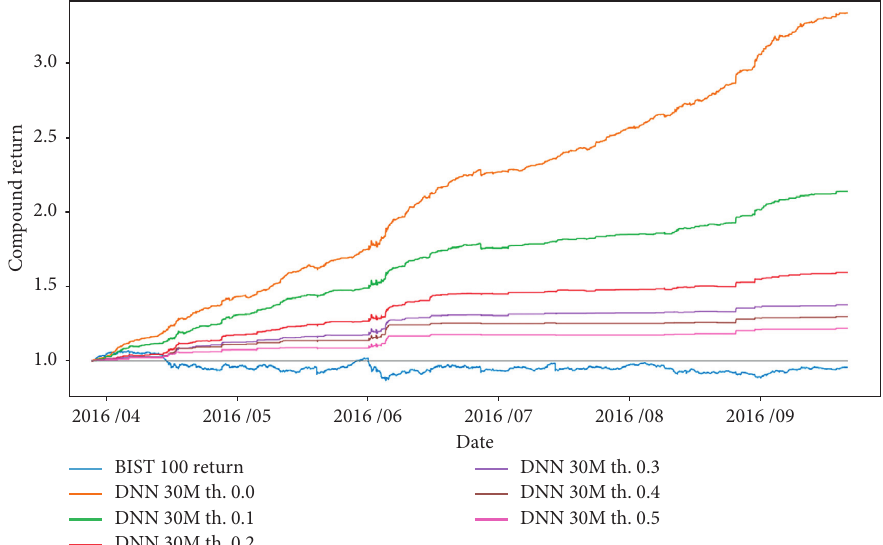
Figure 6: Comparison of one of the worst periods of BIST 100 index with the return of 30 min